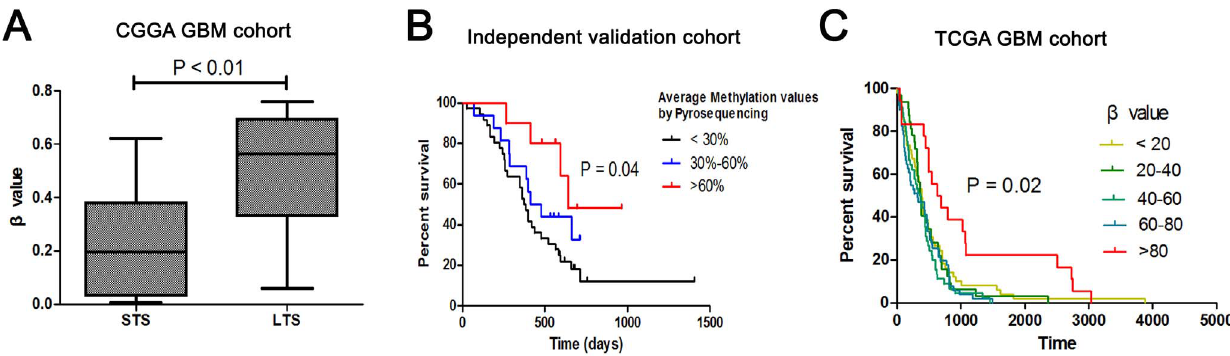
Figure 1. SOCS3 methylation status in STS and LTS group and validiation cohort. A. In the CGGA GBM cohort, the b values of the SOCS3 promoter of the two groups (STS group and LTS group) are significantly different (P , 0.01). B. In an independent validation cohort, survival analysis showed that three groups divided by average methylation values are significantly different (P , 0.04). C. In the TCGA GBM cohort, the group with b value . 80 percent (red) has a significantly longer survival than the other four groups (P=0.02).